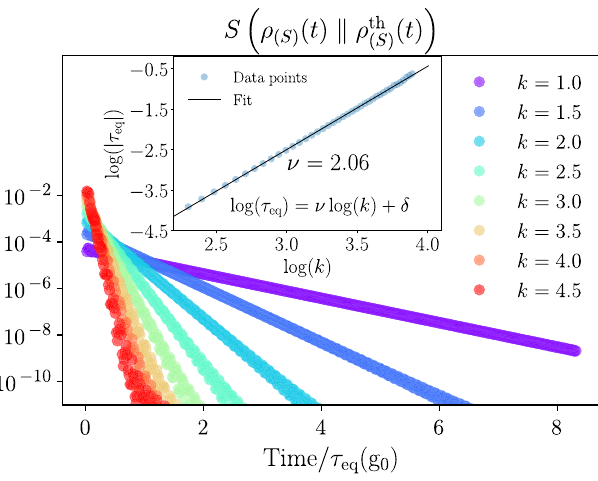
ð t Þ ¼ ð S Þ g Þ ∼ eq ð